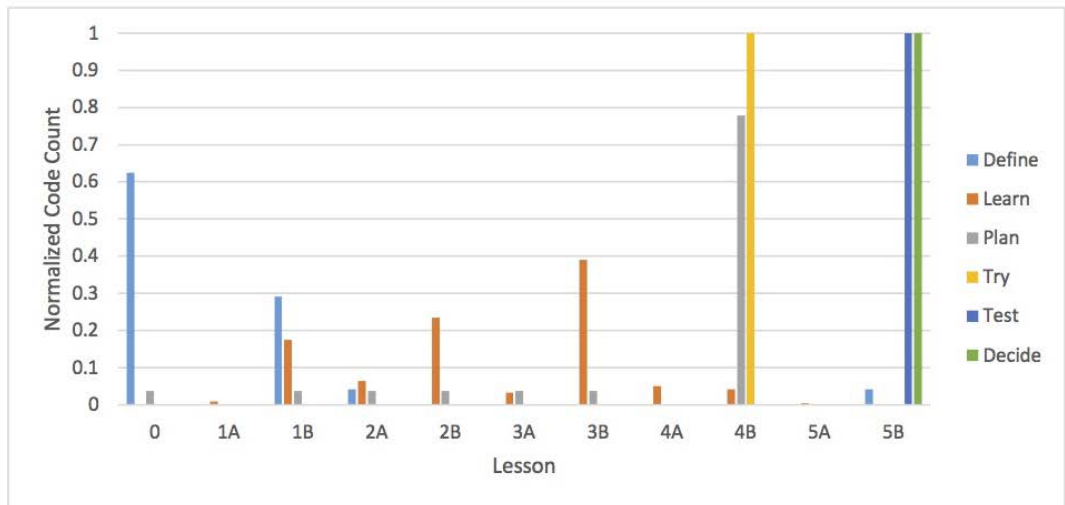
Figure 3. Normalized code count for Engineering Design Process steps across